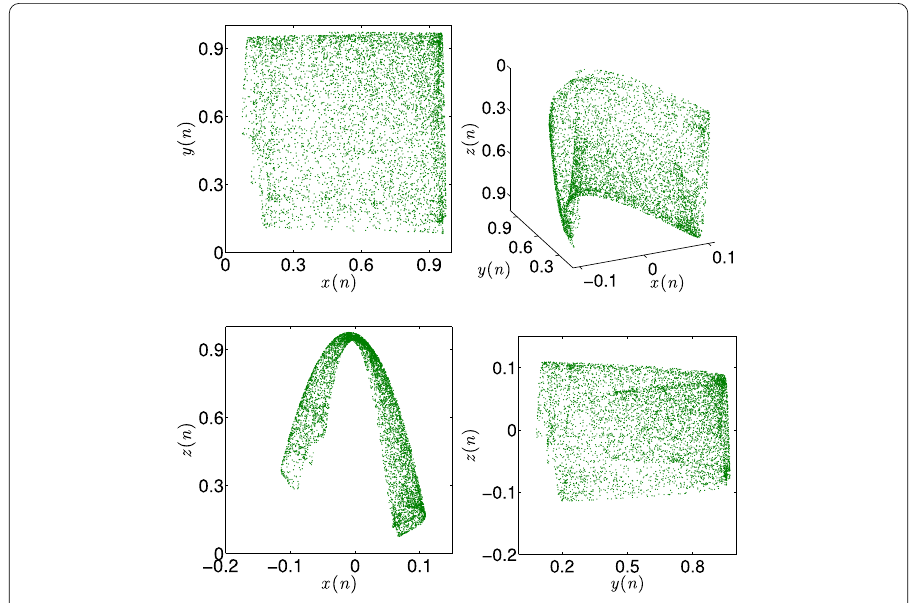
Figure 9 Phase portraits of the fractional order Rössler map for υ = 0.97